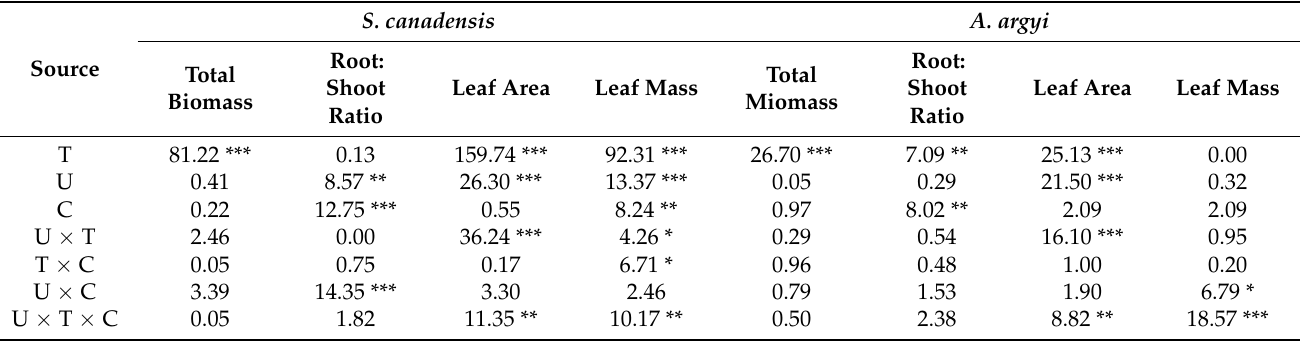
Table 1. Mixed effects analysis of temperature (T), UV light (U), and plant community (C) on growth traits of invasive Solidago canadensis and native Artemisia argyi when grown in monoculture and together in a mixed